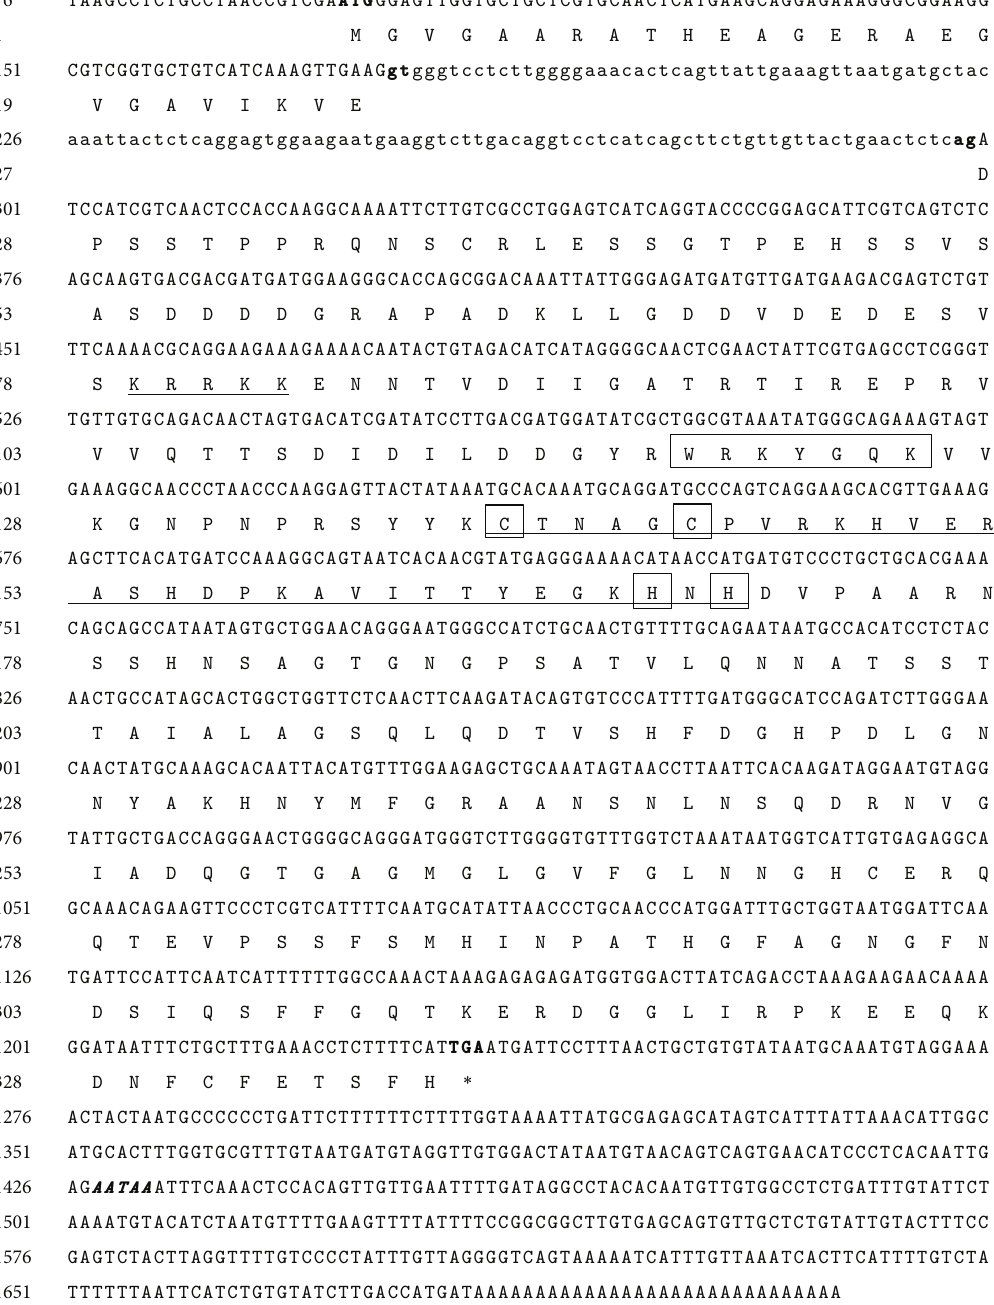
Figure 4: The full-length cDNA, intron, and deduced amino acid sequence of GbWRKY2 gene. The exons sequence is indicated in capital letter and the intron is indicated in lowercase. The start codon (ATG), the stop (TAG), and putative exon-intron splicing sites (gt/ag) are shown by bold letters. One putative polyadenylation signal is bold and italic. A putative nuclear localization signal is underlined. The WRKY domain and the C and H residues in the zinc finger motif (CX 4 CX 23 HX 1 H) are boxed. The zinc finger motif (CX 4 CX 23 HX 1 H) is marked by